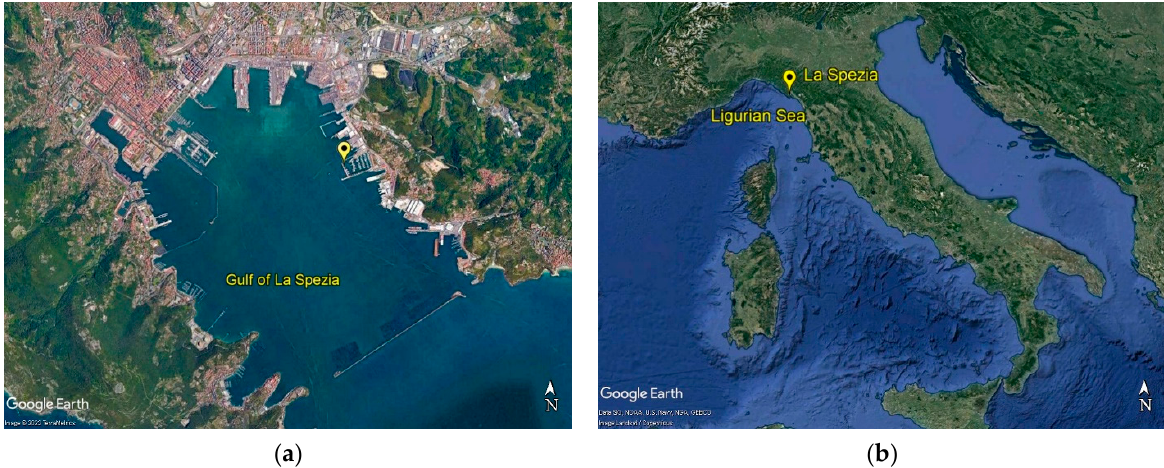
Figure 2. The position of the monitoring station (pictures from Google Earth): ( a ) inside the port of La Spezia; ( b ) within the Eastern Ligurian Sea, Italy.